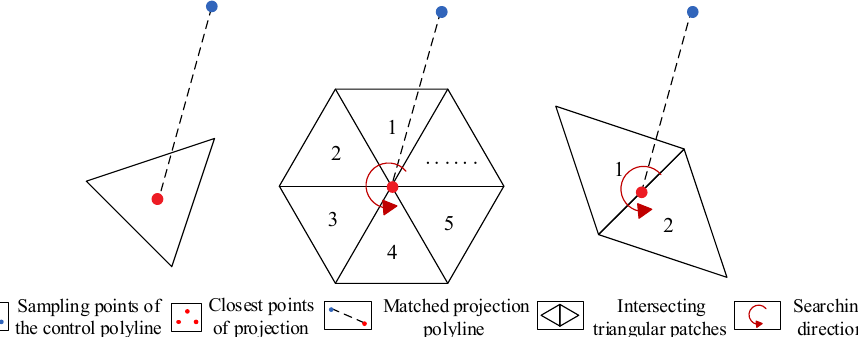
Figure 4. Determination of the intersecting triangular patches according to the projection position of control points.